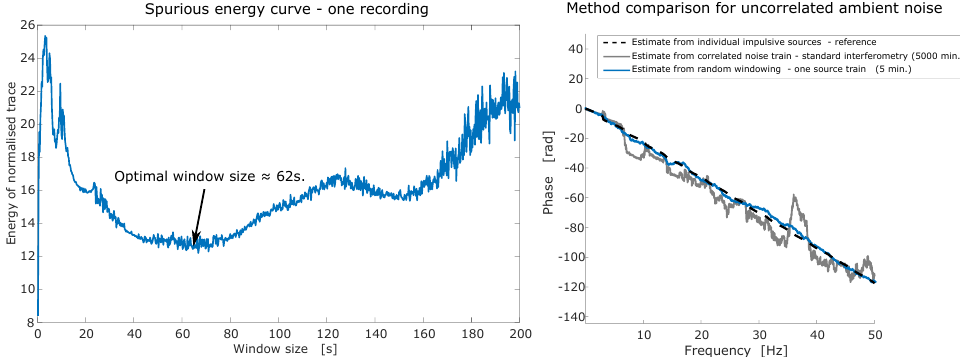
Figure 12. Random windowing method applied to uncorrelated ambient noise. The plot to the left shows the acausal energy curve estimated from one ambient noise recording. The plot to the right shows the resulting estimated phase in blue, which matches the reference phase in black dashes well. For comparison, the phase estimated from stacking 1000 simulated recordings of ambient noise five minutes long is shown in dark gray. We can see the stacking in this case will converge to the correct phase estimate as expected for truly uncorrelated ambient noise, but only after a very large number of ambient noise recordings are processed and